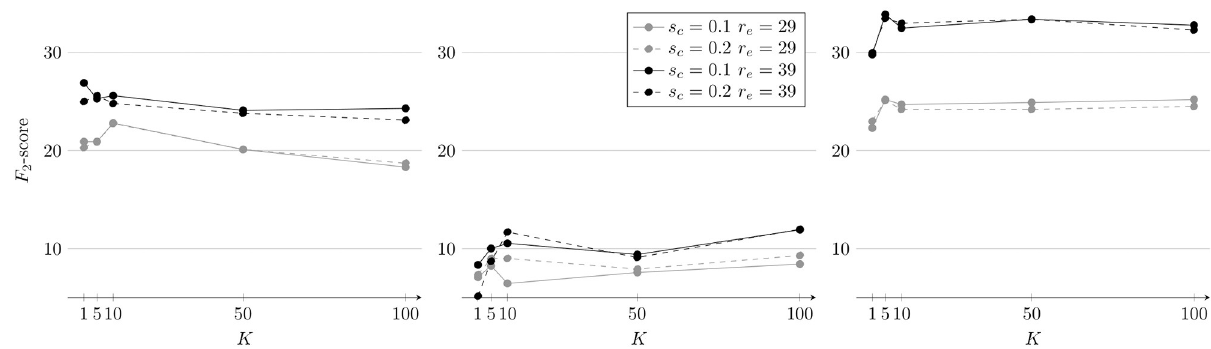
Fig 6. The F 2 -scores of each parameter triplet of the AEN parameter search for V JC77 (left), V PAP (center) and V SO242 (right).